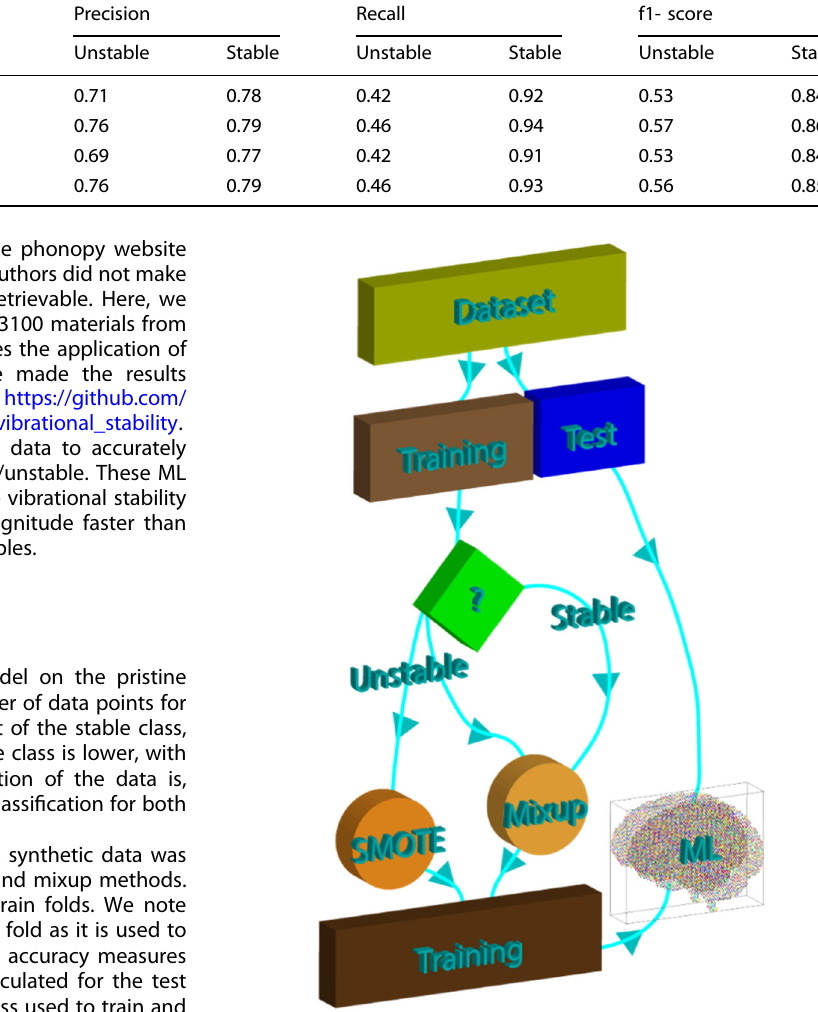
Table 1. The average and maximum classi fi cation metrics that were obtained using vanilla RF and GB classi fi ers across fi vefolds. Model Precision